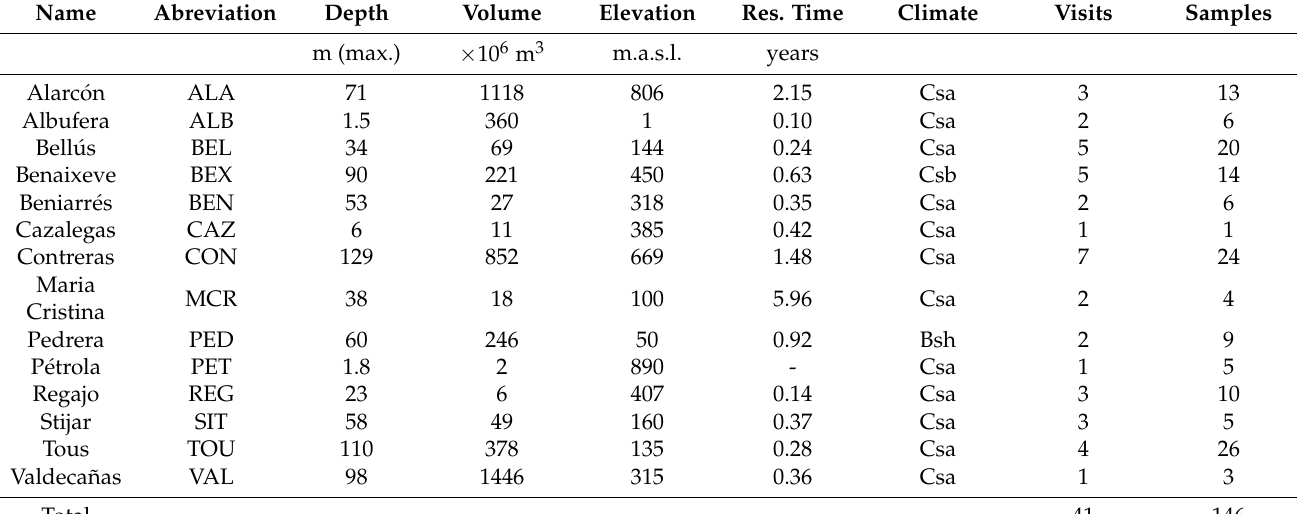
Table A1. Summary of sampled lakes and reservoirs characteristics. Symbols and